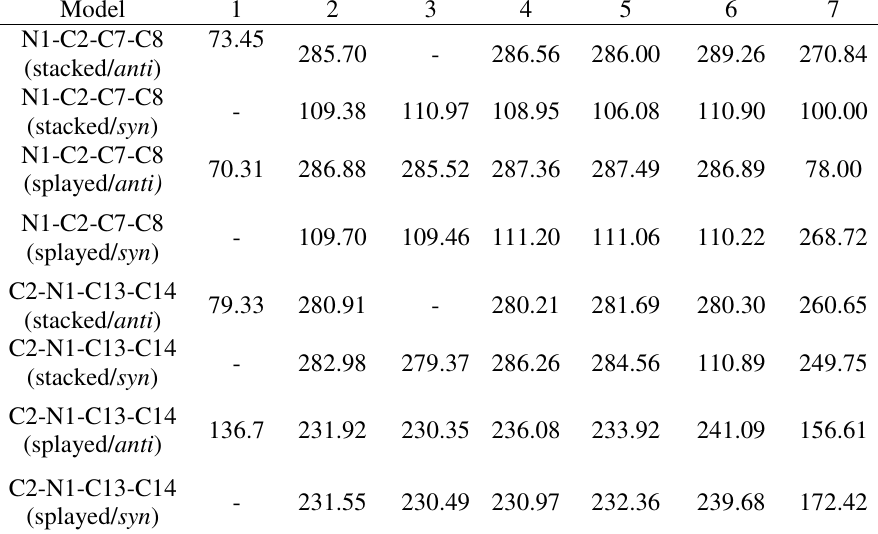
Table 1. Comparison of dihedral angles in studied models (The angles are in